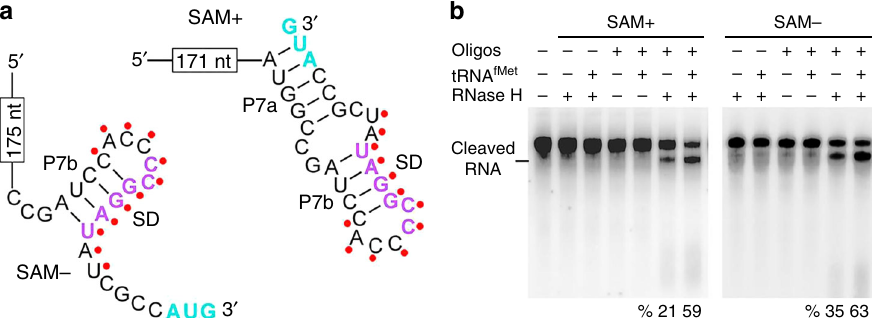
Fig. 3 The binding of SAM-I Xcc with tRNA fMet leads to structural changes and release of SD sequence. a The secondary structure of the 3 ′ region of SAM-I Xcc in the presence ( + , right) and absence ( − , left) of SAM. Nucleotides highlighted by red dots were chosen for the hybridization with a synthetic complementary DNA oligo. b Observation of the SD release upon tRNA fMet binding to SAM-I Xcc . Conformational changes in the SD region were monitored by using the antisense DNA oligo and RNase H cleavage analysis. Cleaved DIG-labeled SAM-I Xcc RNA was pointed out, and the cleavage yield was calculated. Source data are provided as a Source Data fi le.